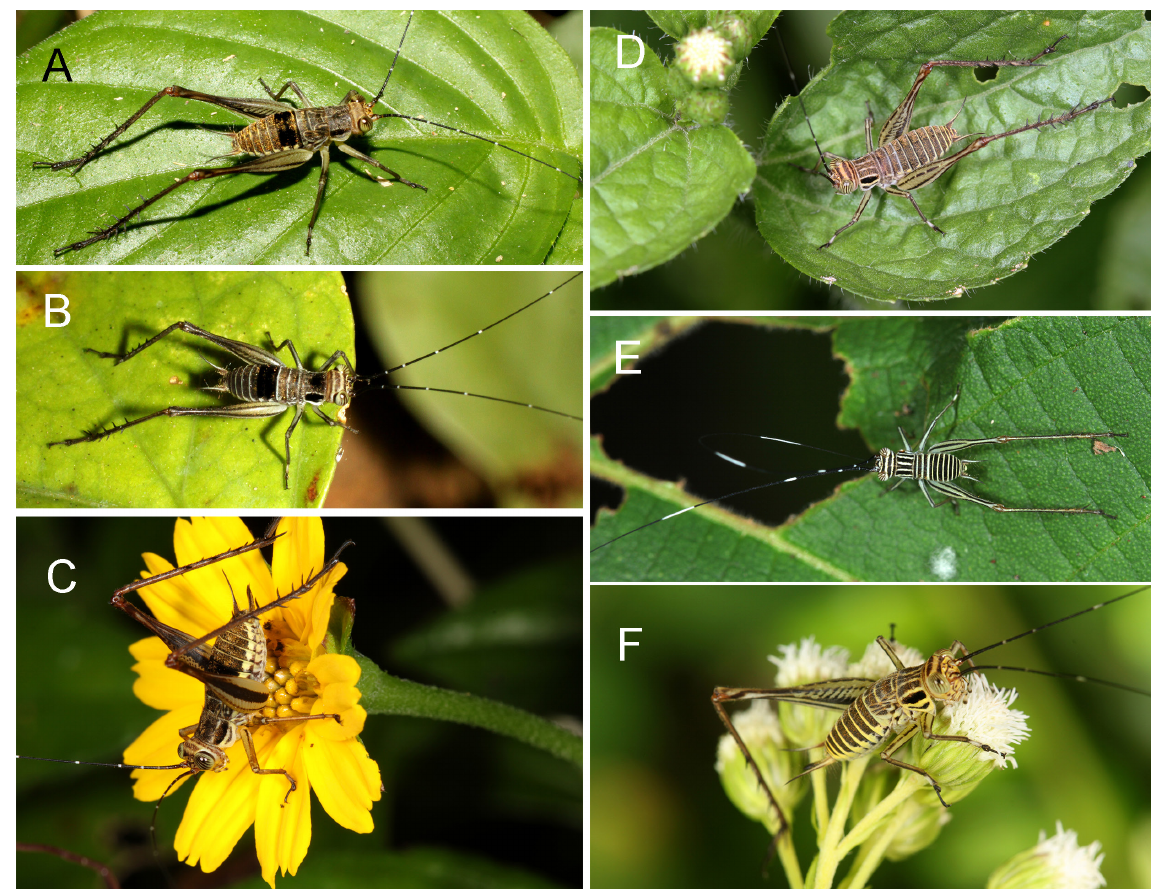
Fig. 24. Nymphs in their natural environment. A–C . Nisitrus malaya Robillard & Tan sp. nov. D–F . N. vittatus (Haan, 1844). Photograph credit: Ming Kai